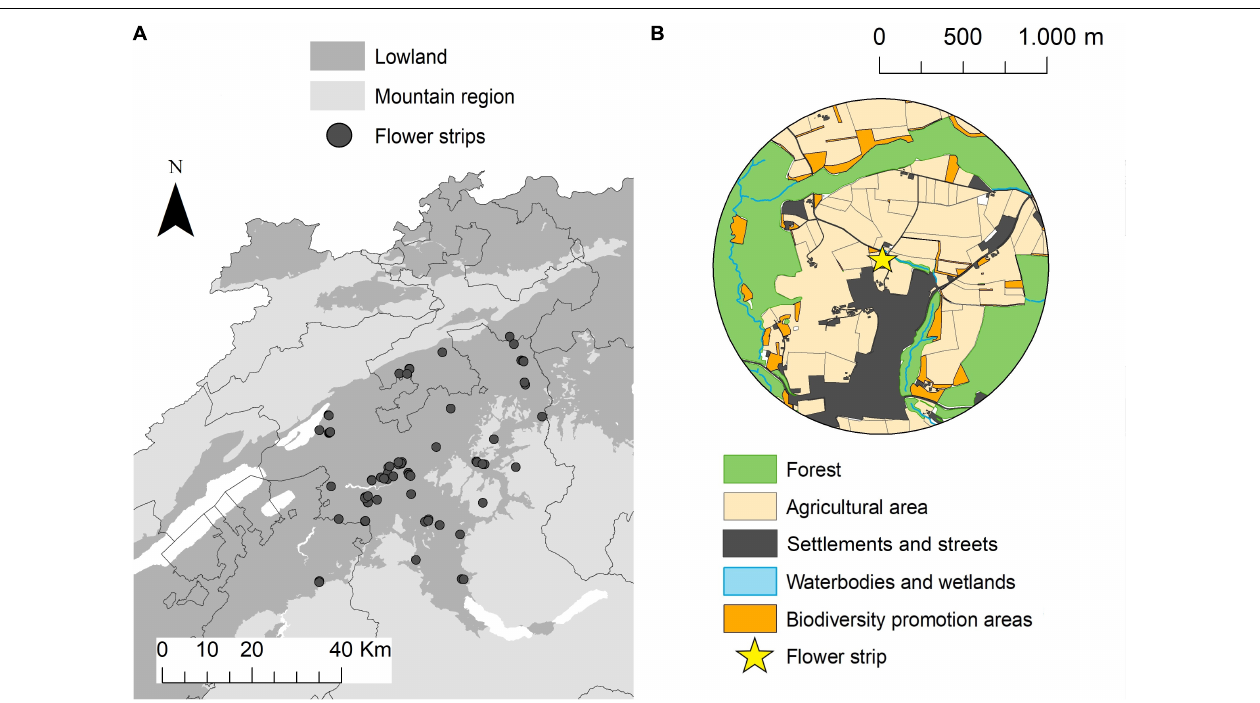
FIGURE 1 | Map of the study area with the ( n = 74) flower strip locations (A) . Example of a study landscape with a 1 km radius surrounding flower strips in the center and different land use types (B)